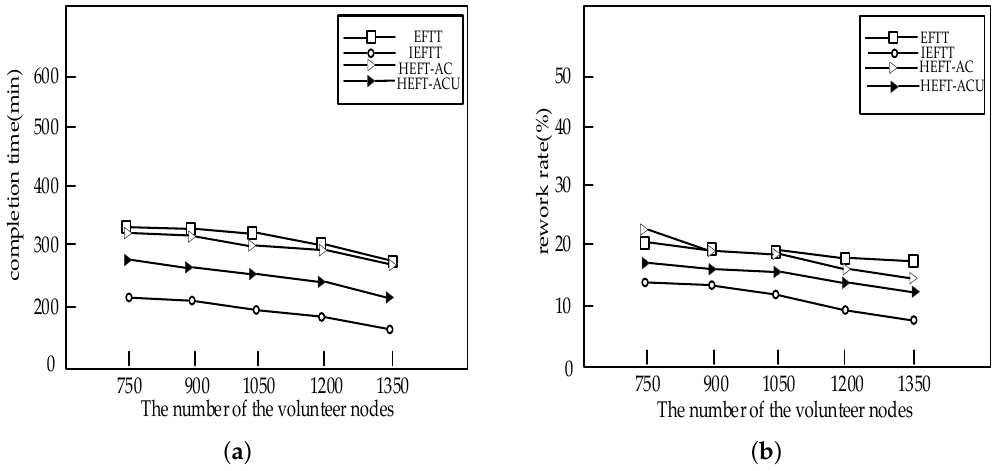
Figure 12. The impact of the number of volunteer nodes on the performance of the algorithms: ( a ) The impact of the number of volunteer nodes on completion time; ( b ) The impact of the number of volunteer nodes on rework